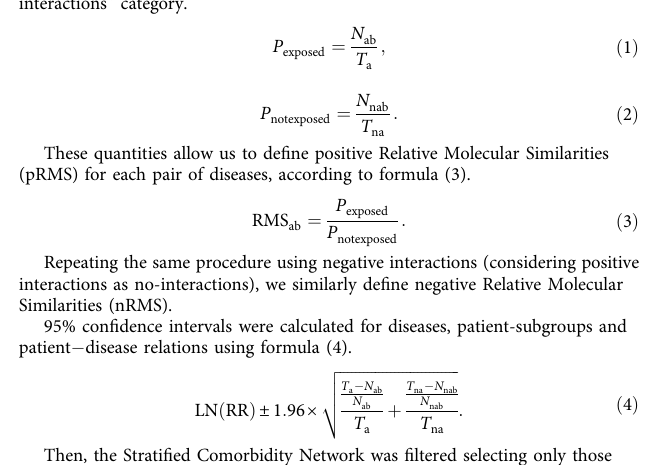
Fig. 6 Personalized comorbidity pro fi les. Two steps are necessary to generate patient-speci fi c comorbidity pro fi les with associated drugs. a Generate a drug pro fi le for each disease. Based on patient-speci fi c differential expression pro fi les, associate to each patient the drugs that generate expression changes similar or opposite to the ones observed in the patient based on LINCS. Generate a drug pro fi le calculating for each drug within each disease the percentage of patients to whom they are positively associated. Do the same with all the diseases. b Generate a personalized comorbidity pro fi le. For each patient, based on molecular similarities, calculate the relative risks of developing secondary diseases based on relative molecular similarities. Associate the patient with the drugs that generate expression changes similar and opposite to the ones observed in the patient using LINCS. Select the overlap between drugs associated with the patient and those associated with each disease. Of those, fi lter the fi rst-line treatments. The resulting drugs are the ones that might be involved in the increased risk of developing the detected secondary